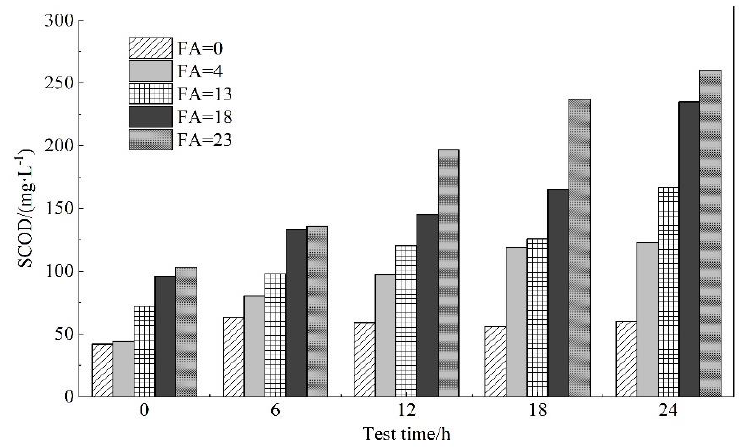
Figure 6. The influence of different FA on SCOD in sludge.